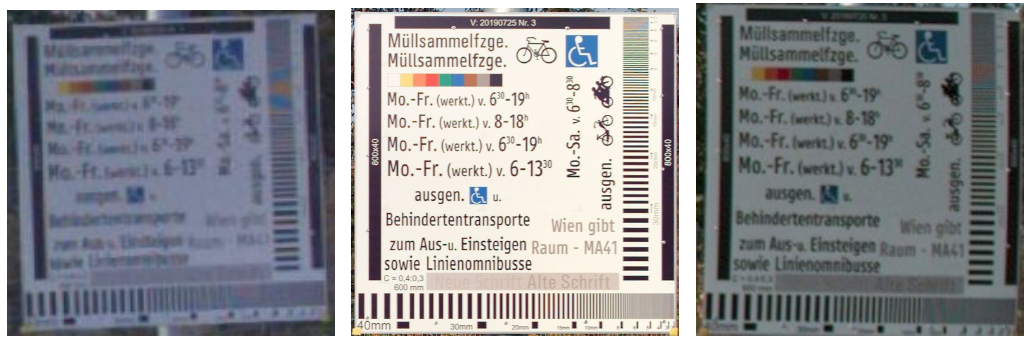
Figure 5. Orthogonal images of the test chart at a distance of 5m. From left to right: System A, B,